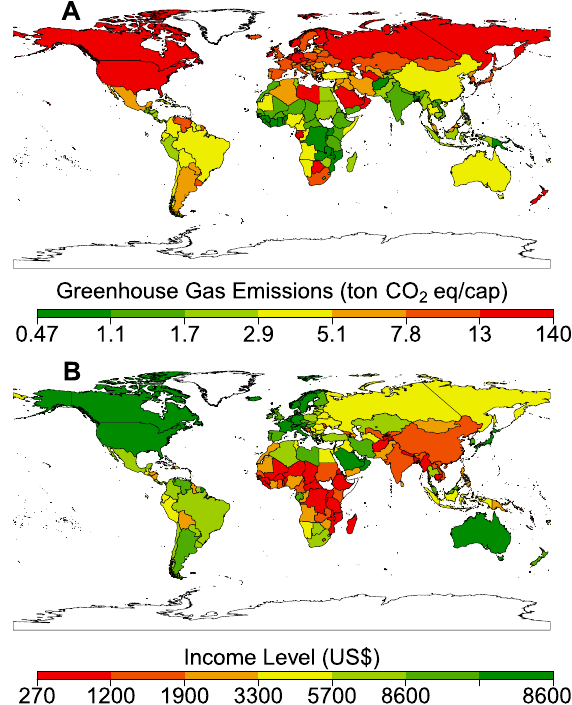
Fig. 2 Geographical distribution of (A) GHG Emissions (B) Income Level. From green to red in A denotes low to high GHG emissions, whereas from red to green in B denotes low to high-income level. The method of country- level data categorization was based on quantiles, used to capture continuous intervals with uniform distribution. A — mean: 7.95, min: